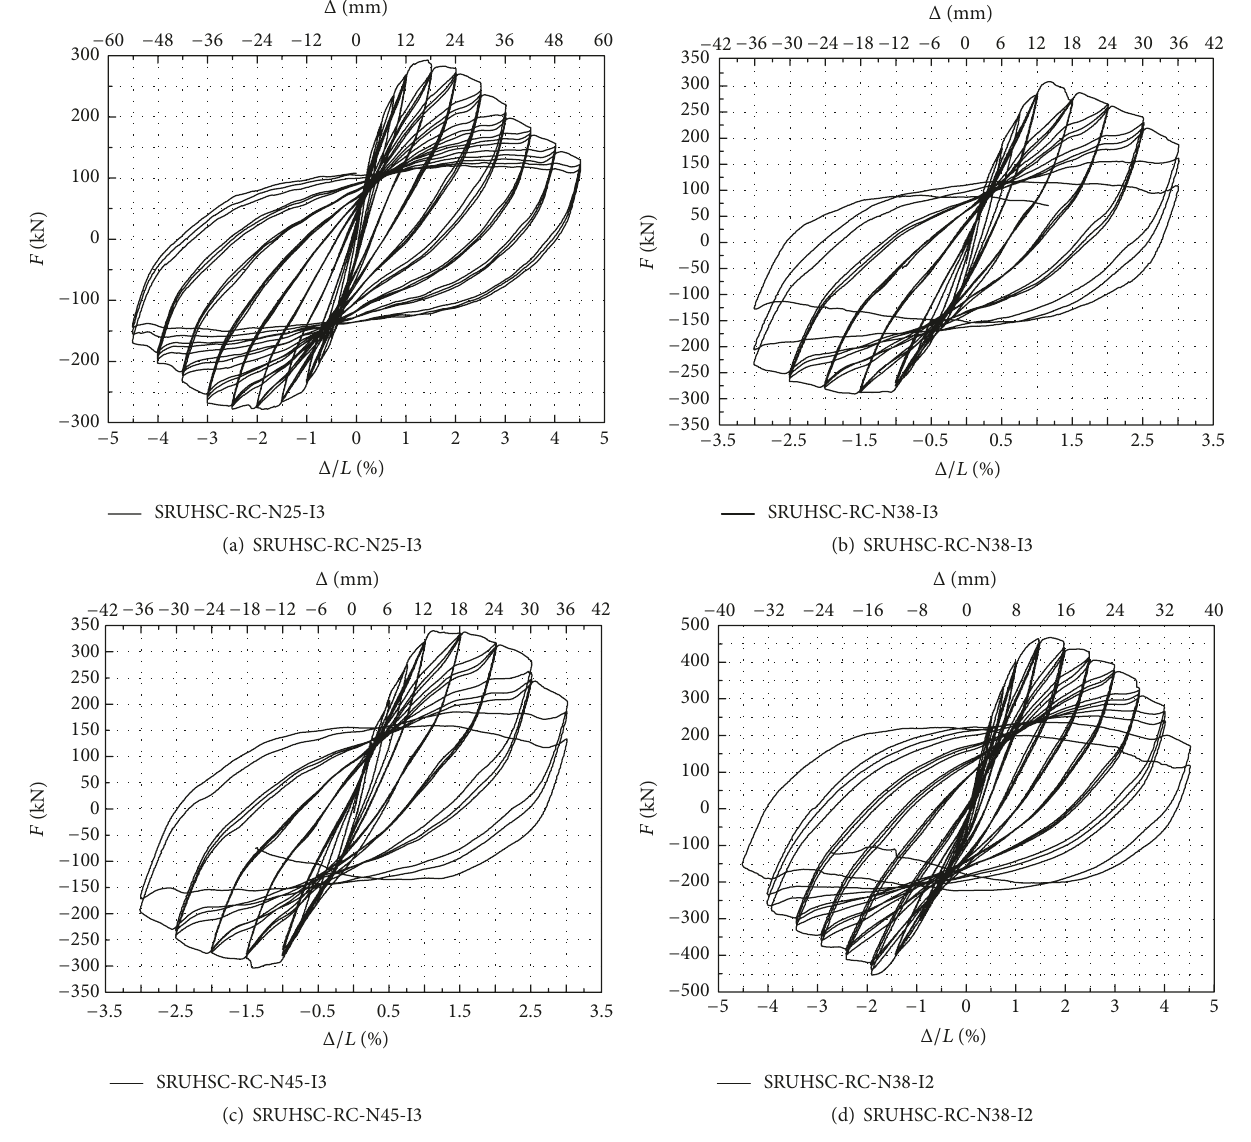
Figure 6: Hysteretic curve of the SRUHSC